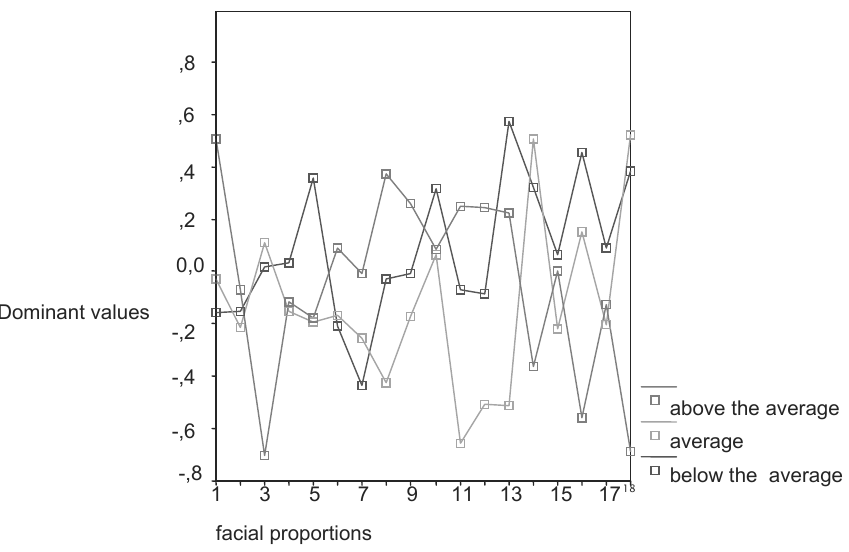
Fig. 2. Relation between facial metric parameters and desirable to date – not desi- rable to